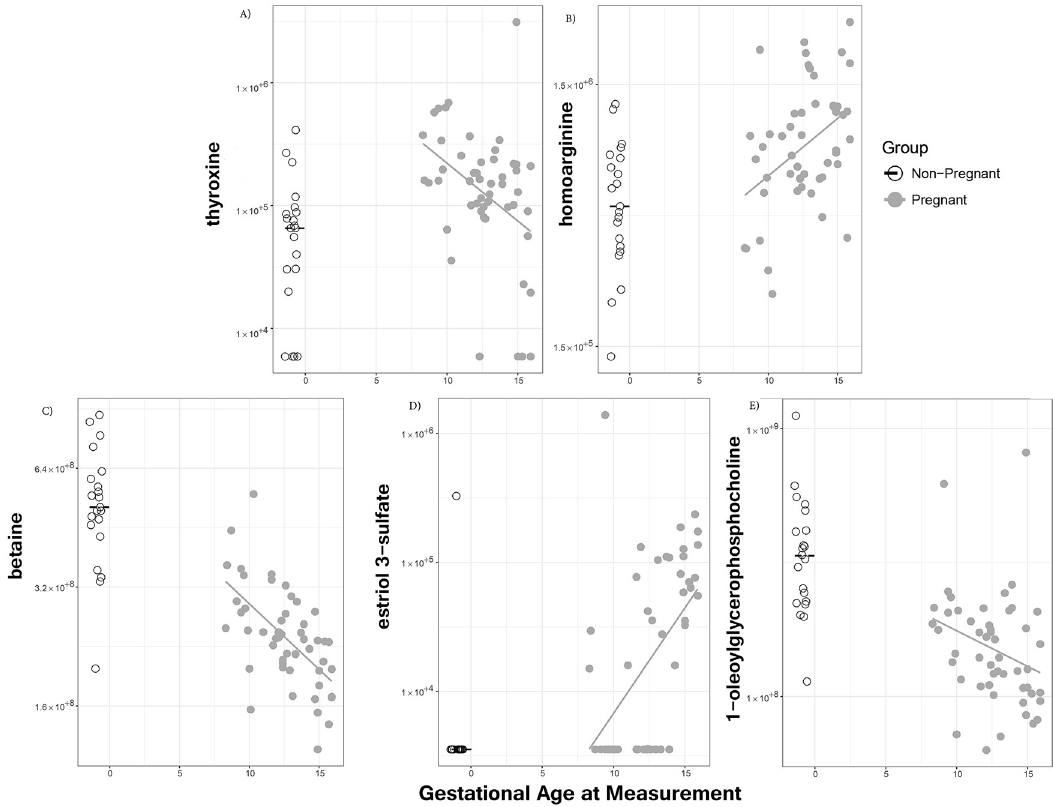
Fig 3. Metabolites associated with gestational age. Each panel shows metabolite abundance (on the vertical axis) vs . gestational age in weeks (on the horizontal axis). Non-pregnant women are shown to the left of gestational age 0 on the horizontal axis, with dither added so that points can be distinguished. Each point corresponds to one sample; linear regression lines are shown for pregnant women, and median values are shown for non-pregnant women.